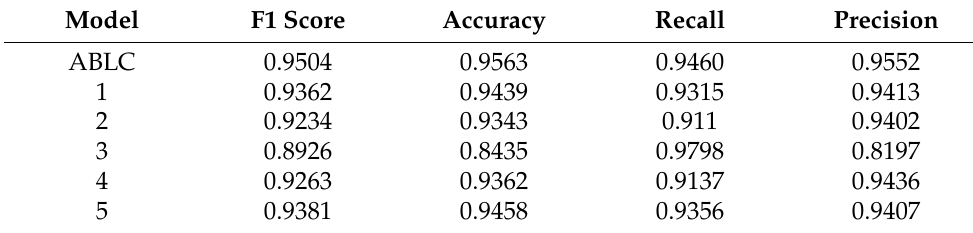
Table 5. Parameter experiment comparison